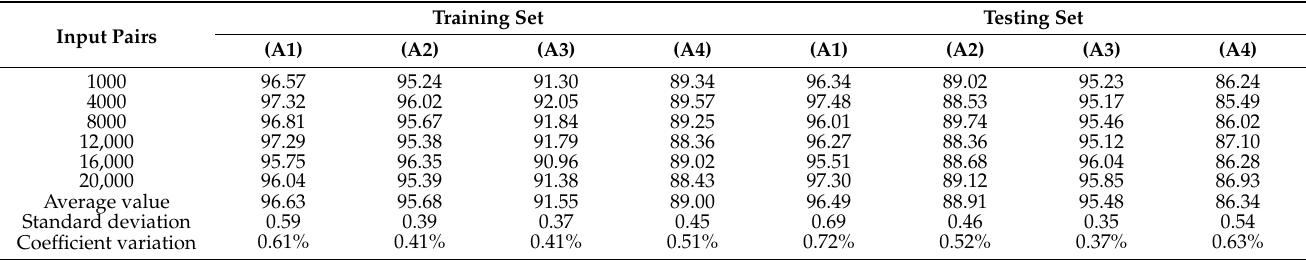
Table 4. Satisfaction rate of measuring criteria for steam-water systems